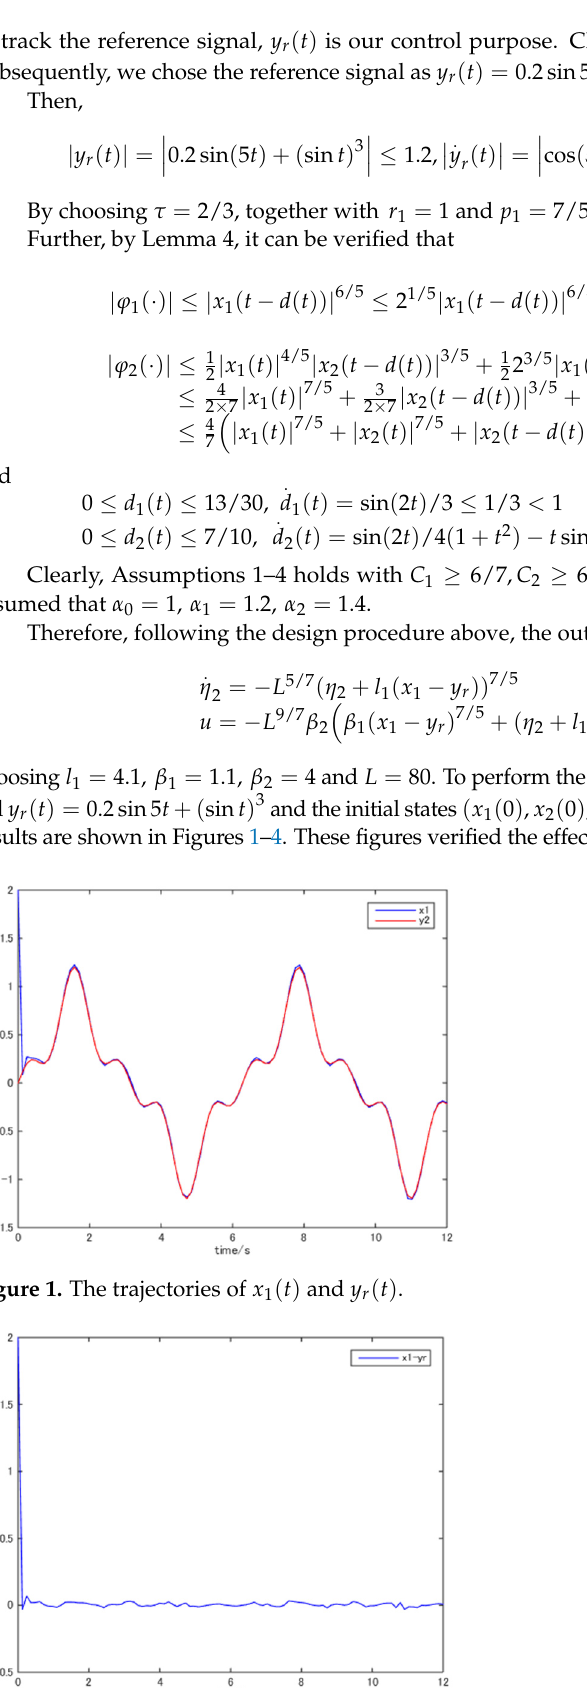
Figure 3. The trajectory of state 2 ( ) x t .